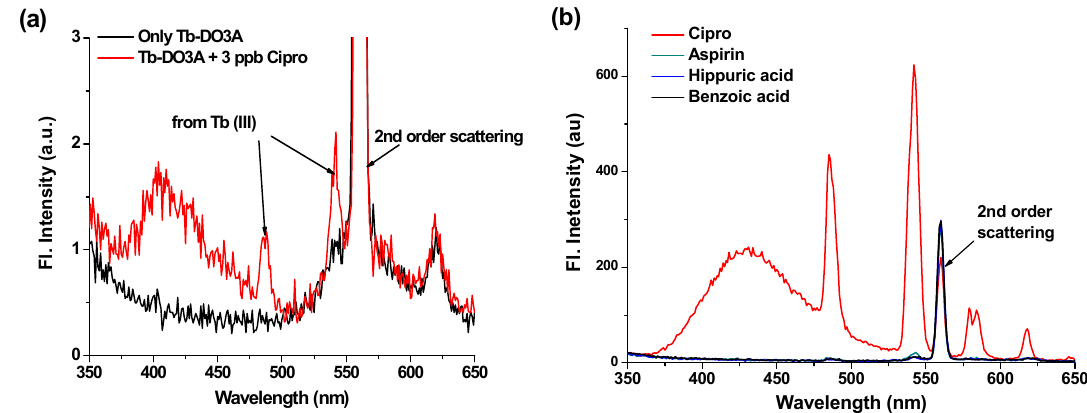
Figure 5. ( a ) Emission changes of Tb-DO3A (5 µM) upon addition of Cipro (3 ppb). The fluorescence data were obtained by excitation at 278 nm in HEPES buffer (pH = 7.4). This data shows a signal-to-background ratio of more than three. ( b ) Selective luminescence response of Tb-DO3A (10 µM) towards Cipro over other analytes possibly present in urine, such as aspirin, hippuric acid, and benzoic acid. Each of the analytes was added at a concentration of 20 µM in HEPES Buffer (pH = 7.4). The spectra were recorded under excitation at 278 nm.